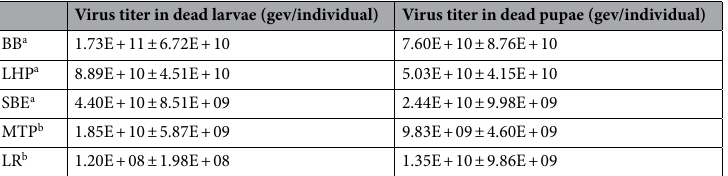
Table 1. Mean viral copy number of AalDV2 in dead larvae and pupae for each tested strain of Ae. aegypti (LHP, Long-Hoà, BB, Bora-Bora and SBE, Benin) and Ae. albopictus (MTP, Montpellier and LR, La Réunion). Larvae (N = 3 replicates of 150 larvae per experimental condition) were infected or not, with 3 × 10 11 veg/ml of AalDV2. Viral doses of dead larvae and pupae are expressed as the number of AalDV2 genomes quantified by qPCR in each individuals (gev/individual). a Aedes aegypti ; b Aedes albopictus.